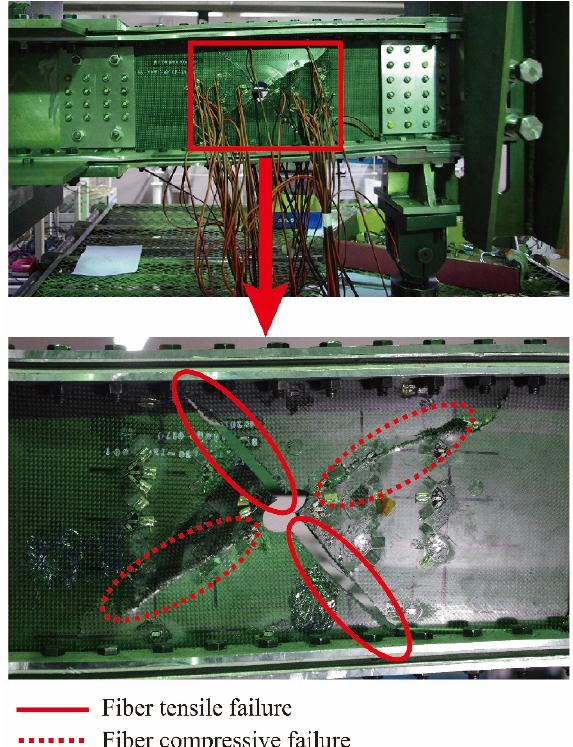
Figure 13. The failure state of the BW-II-01 composite beam after the collapse under shear load.